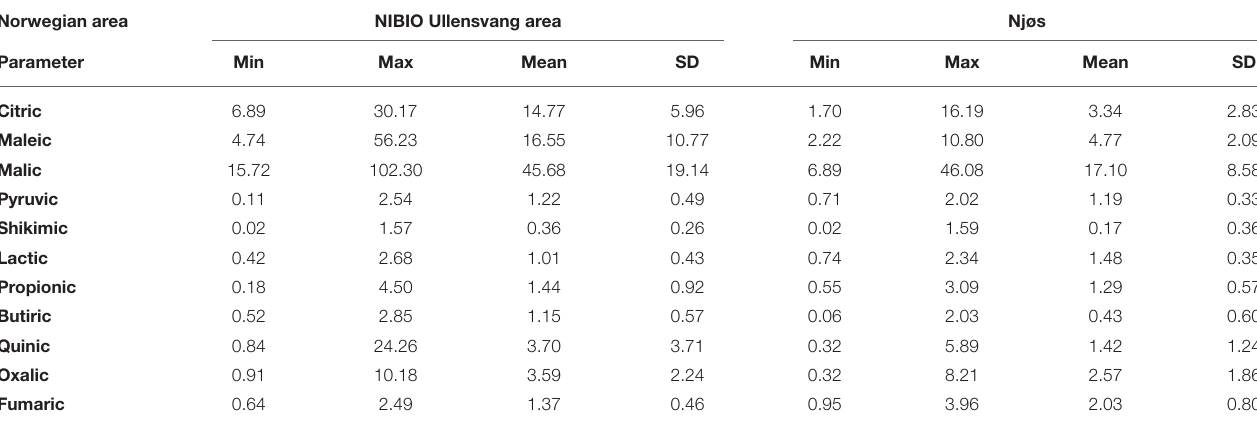
TABLE 2 | Descriptive analysis of organic acids content (g/kg dw) in Norwegian apple samples from the NIBIO Ullensvang area (no. 1–74) and from Njøs (no. 75–103) during 2-year harvesting. Norwegian